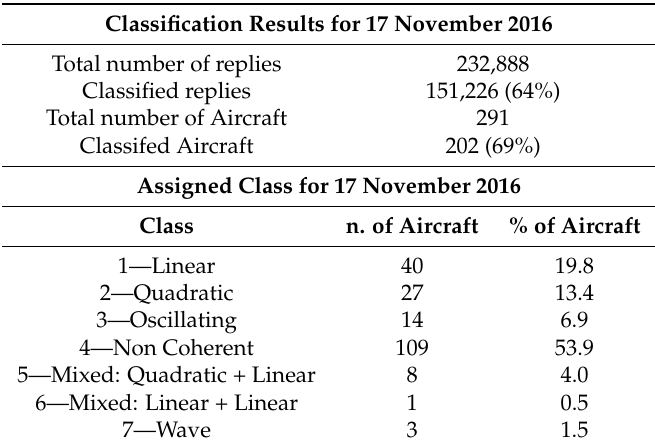
Table 1. Classification results for 17 November